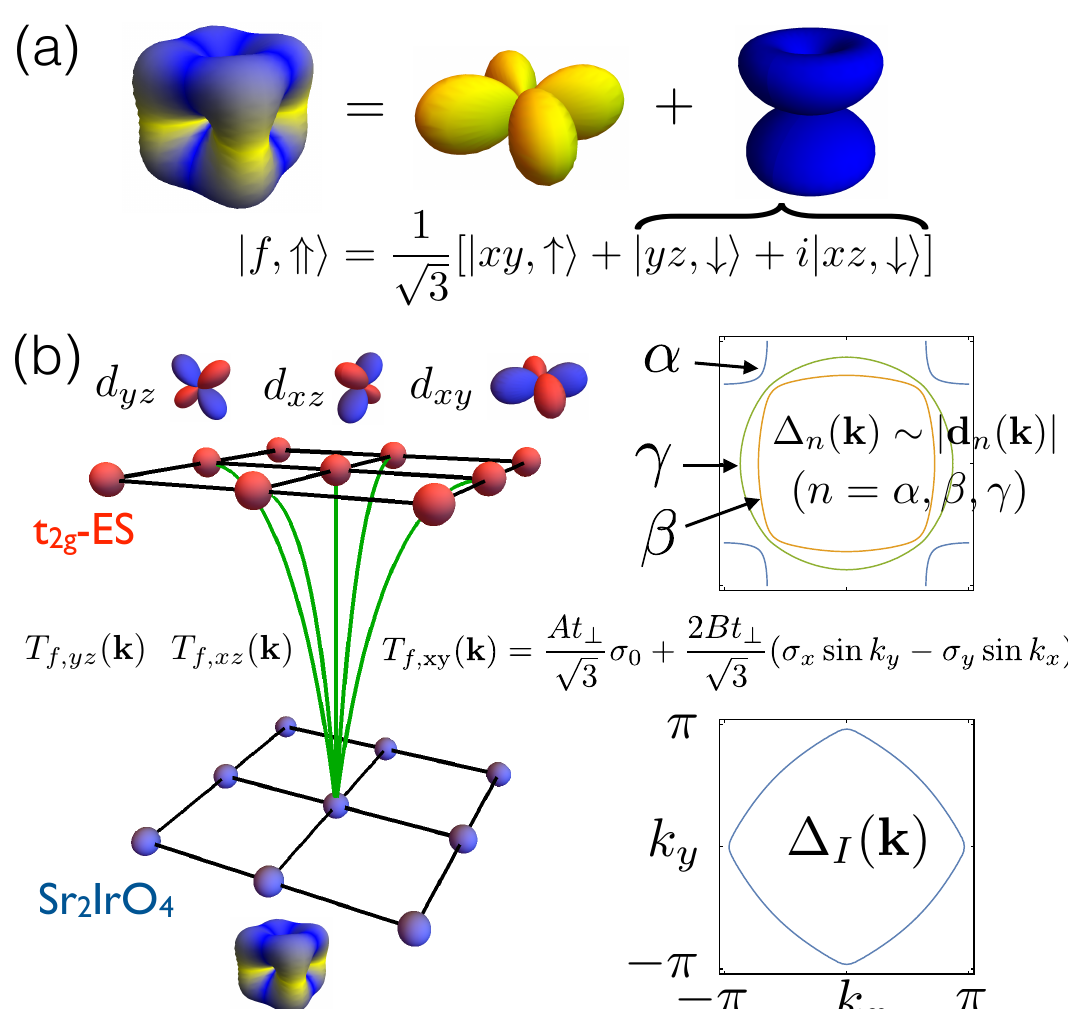
Figure 1: (a) Due to the strong spin-orbit coupling the active pseudospin orbitals in Sr IrO 2 4 are described by strongly entangled spin and orbital degrees of freedom. (b) When Sr IrO is 2 4 tunnel coupled to a t electron system, the tunneling of the pseudospin singlet Cooper pairs 2 g [ described by the order parameter ∆ ( k ) ] into the t -ES leads to an apperance of singlet I 2 g ∆ ( k ) and triplet d ( k ) components of the induced order parameter in each band n = α , β , γ n n ( k ) ∼ | d ( k ) | leading of the t -ES. These order parameters can have similar magnitudes ∆ n n 2 g to a possibility of a robust semi-Dirac